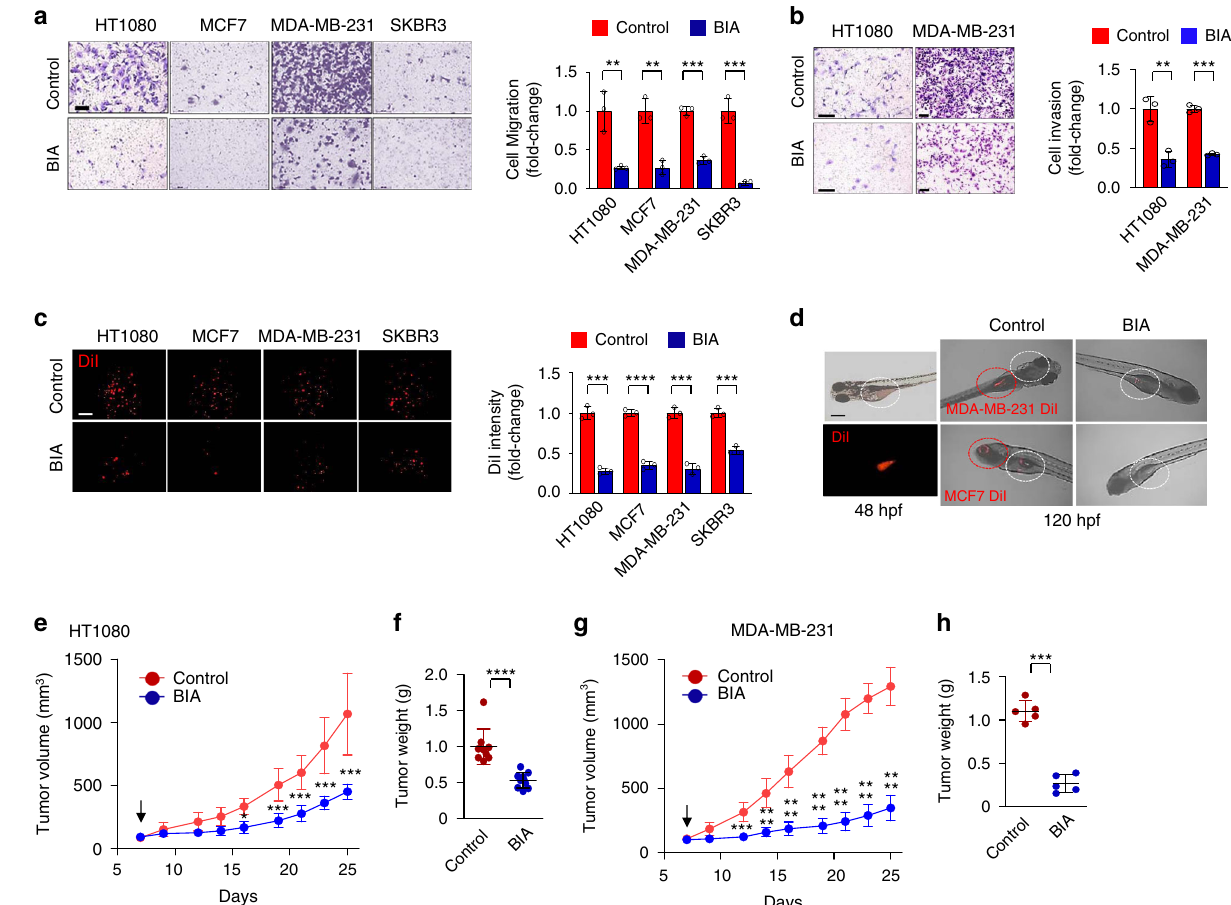
Fig. 8 BIA inhibits tumor growth. a Images of migrated cells in HT1080, MCF7, MDA-MB-231, and SKBR3 cells treated with 2.0 μ M BIA. Right, quanti fi cation of migrated cells in the BIA-treated cells normalized to control cells ( n = 3 independent experiments). Data are presented as means ± SD. ** p < 0.01, *** p < 0.001, two-tailed unpaired t -test. Scale bar, 15 μ m. b Images of invasive cells in HT1080 and MBA-MB-231 cells treated with 2.0 μ M BIA. Right, quanti fi cation of invasive cells in BIA-treated cells normalized to control cells ( n = 3 independent experiments). Data are presented as means ± SD. ** p < 0.01, *** p < 0.001, two-tailed unpaired t -test. Scale bar, 15 μ m. c DiI fl uorescence images of the indicated cell lines after 7 days of 3D culture. Right, quanti fi cation of the intensity of fl uorescence in the BIA-treated cells normalized to control cells ( n = 3 independent experiments). Scale bar, 15 μ m. Data are presented as means± SD. *** p < 0.001, **** p < 0.0001, two-tailed unpaired t -test. d Images of control and BIA-treated zebra fi sh after injection of indicated cell lines into embryos. White and red circles represent cell injection and migration sites, respectively. Images represent one of nine experiments, with similar results obtained. Scale bar, 100 μ m. e , f Volume and weight of tumors derived from HT1080 cells injected into nude mice treated with vehicle or 1 mg/kg BIA (vehicle; n = 9, BIA; n = 11 mice). Data are presented as means ± SD. * p < 0.05, *** p < 0.001, **** p < 0.0001, two-way ANOVA followed by Bonferroni ’ s post hoc test in ( e ) and two-tailed unpaired t -test in ( f ). g , h Volume and weight of tumors derived from MDA-MB-231 cells injected into nude mice treated with vehicle or 1 mg/kg BIA ( n = 5 mice per group). Data are presented as means ± SD. *** p < 0.001, **** p < 0.0001, two-way ANOVA followed by Bonferroni ’ s post hoc test in ( g ) and two-tailed unpaired t -test in ( h